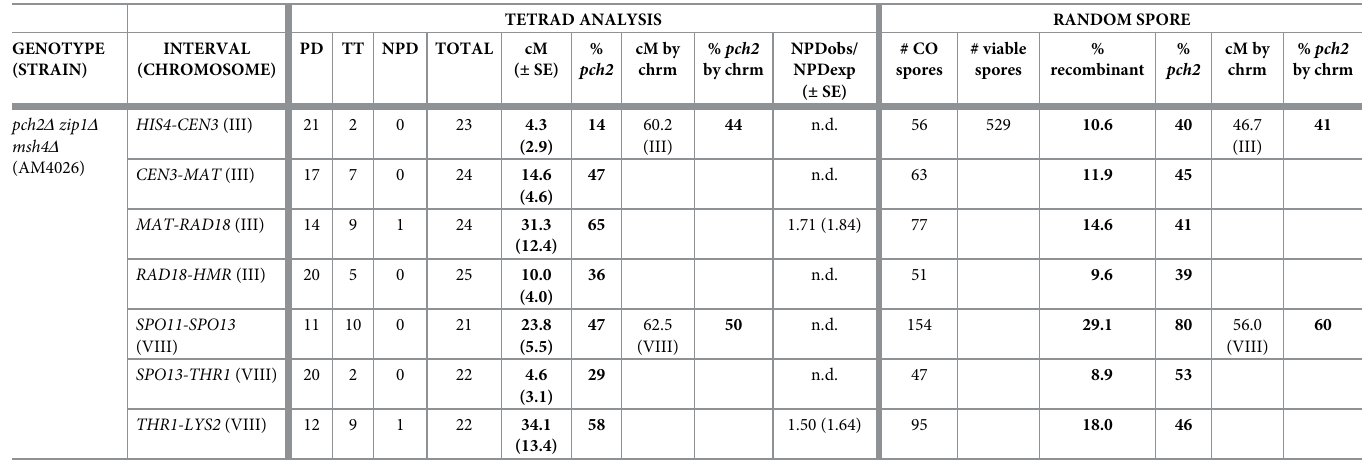
Removal of residues 2–9 or 10–14 results in a novel separation-of-function Zip1 protein that is crossover-deficient but synapsis-proficient Residues 21–163 within Zip1’s N terminal unstructured region are dispensable for Zip1’s func- tion in crossover recombination but essential for tripartite SC assembly [24]. We investigated whether residues 2–20 are critical for the formation of mature SC by asking whether coinci- dent linear structures of the SC transverse filament protein (Zip1) and the SC central element protein Ecm11 assemble on surface-spread meiotic prophase nuclei from strains carrying wild-type or a mutant zip1 allele and missing the Ndt80 transcription factor. Ndt80 is required for progression beyond a mid-meiotic prophase stage when full-length SCs are normally assembled [42], thus the ndt80 null background allows us to maintain cells in sporulation medium for prolonged periods in order to assess the overall capacity of a strain to assemble SC. We utilized a polyclonal antibody targeted against Zip1’s C terminal 264 residues [43] together with an antibody against the MYC epitope tag that is fused to the C terminus of one copy of the ECM11 gene in these